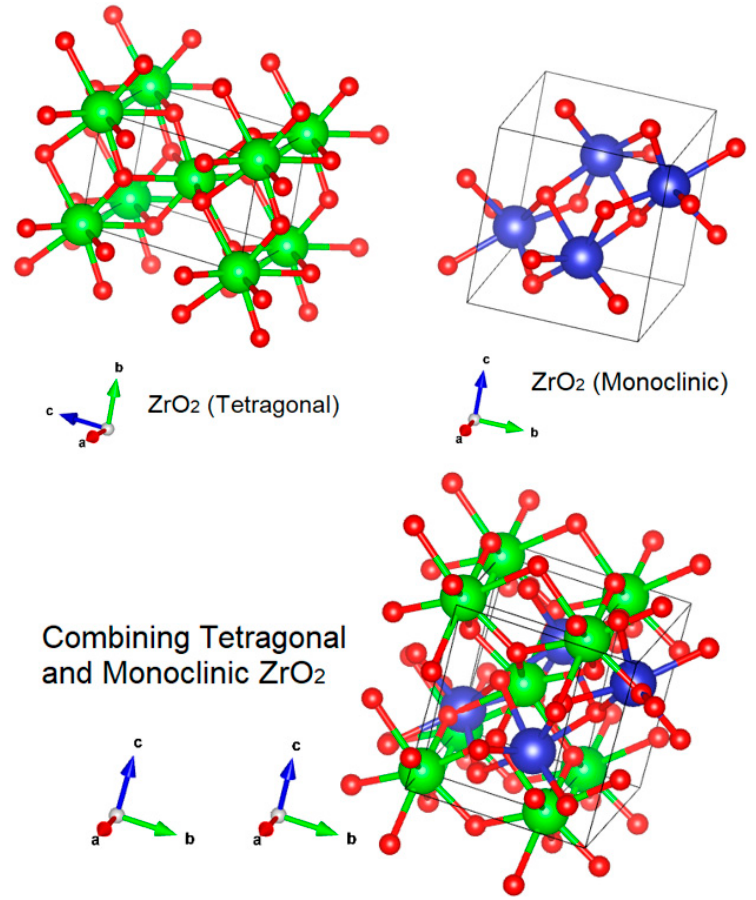
Figure 5. Simulation of the co-existence of tetragonal and monoclinic crystalline phases in ZrO 2 nanotubes annealed at 400 °C.